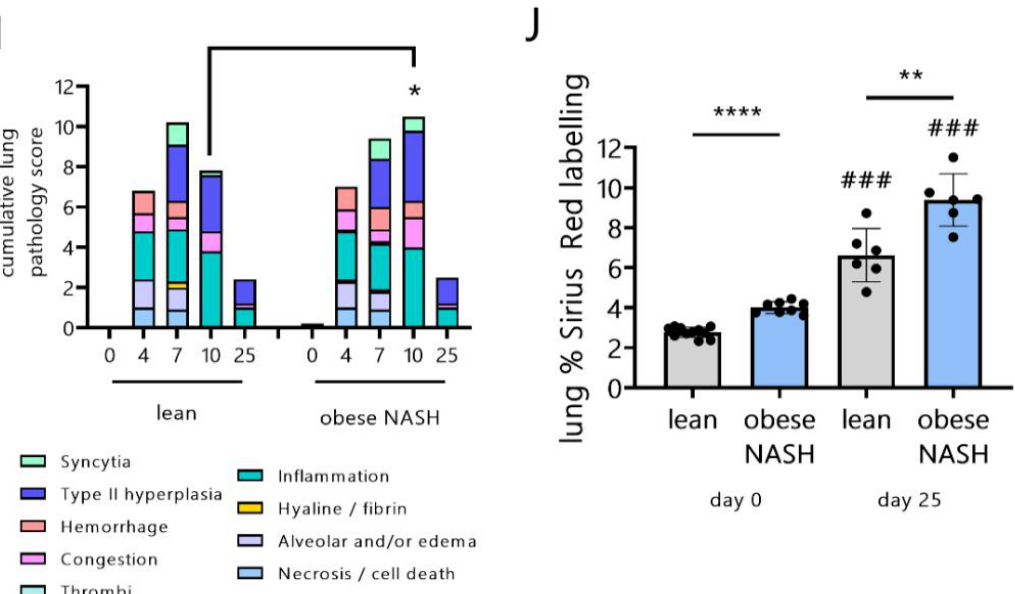
Figure 2. Impact of SARS-CoV-2 infection on lean hamsters vs. obese NASH hamsters. Hamsters were inoculated intranasally with 2 × 104 TCID50 of the clinical SARS-CoV-2 isolate hCoV- 19/France/lDF0372/2020. ( A ) Changes in body weight (as the mean ± SD percentage of the initial